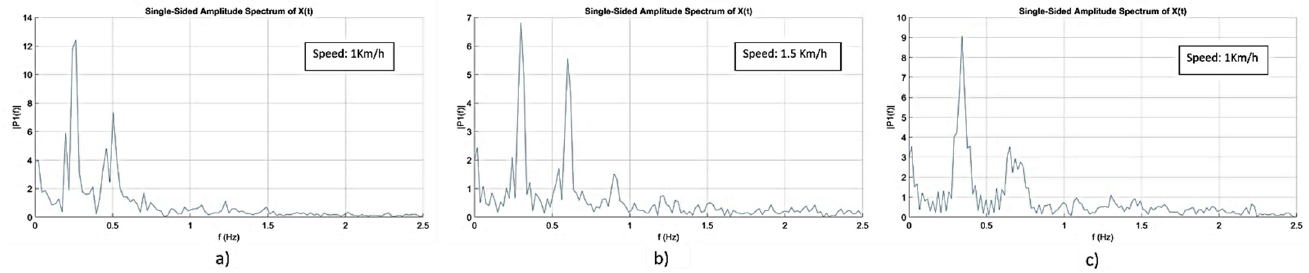
Figure A1. Spectral frequency analysis of the kinematic foot signals represented in Figure 5, for the speeds of: ( a ) 1 km/h, ( b ) 1.5 km/h, ( c ) 2 km/h.